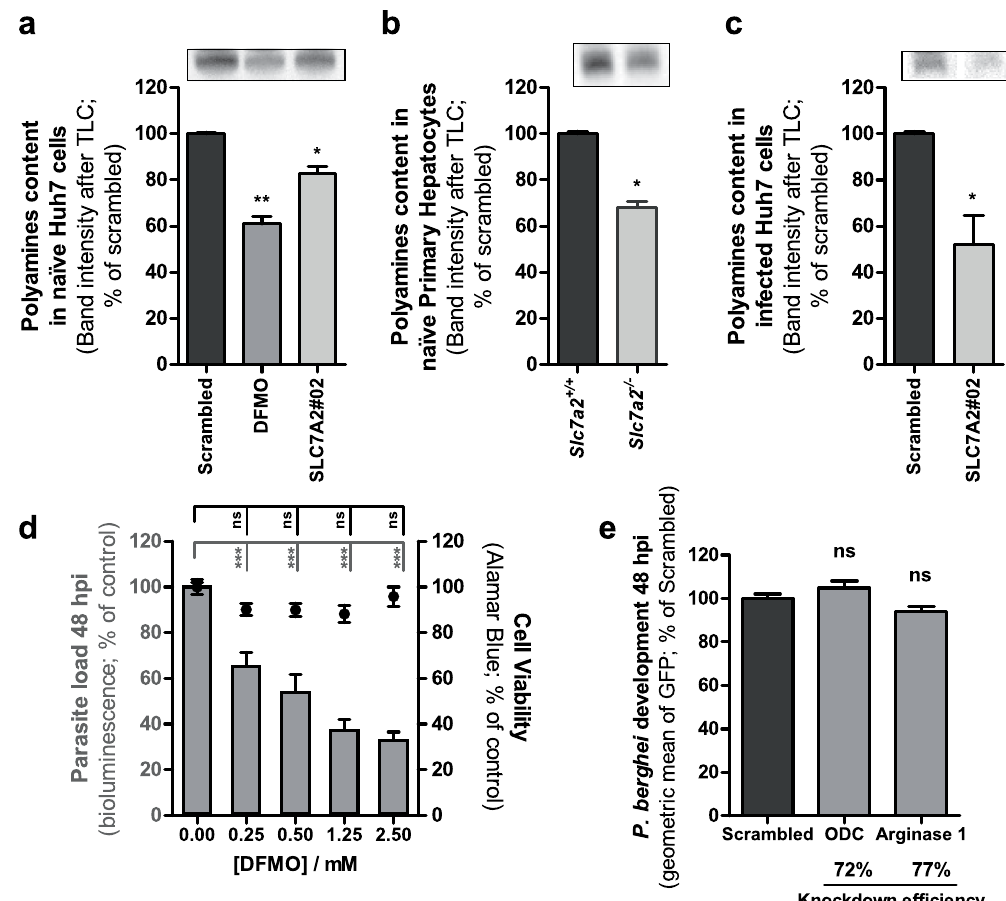
Figure 4. Intracellular polyamine levels are dependent on CAT2A/B function and inhibition of polyamine synthesis by P . berghei decreases hepatic infection. Polyamines were examined by thin-layer chromatography (TLC) of cellular extracts of ( a ) naïve Huh7 cells, ( b ), naïve mouse primary hepatocytes and ( c ) GFP-expressing P . berghei -infected Huh7 cells FACS-sorted at 40 hpi. The amount of each sample was normalized by GAPDH Western blot before analysis. All panels: Top – representative image of polyamines band analyzed by TLC; Bottom – Quantification of band intensities. Representative experiment out of 2 independent experiments. Error bars represent SD of 3 technical replicates. ( d ) Huh7 cells were infected with luciferase-expressing P . berghei sporozoites and the culture medium was replaced by medium with increasing concentrations of DFMO. Parasite load (bioluminescence) and cell viability were assessed at 48 hpi. ( e ) Huh7 cells with the knockdown of ODC and arginase 1 were infected with GFP-expressing P . berghei sporozoites and parasite development was assessed by flow cytometry at 48 hpi. Pool of 3 independent experiments. Error bars represent SEM. ( a ) One- way ANOVA with post-test Dunnett; ( b ) and ( c ) Two-tailed t-test; ( d ) and ( e ) One-way ANOVA with post-test Dunnett. ns - not significant, * p < 0.05, ** p < 0.01 and *** p <